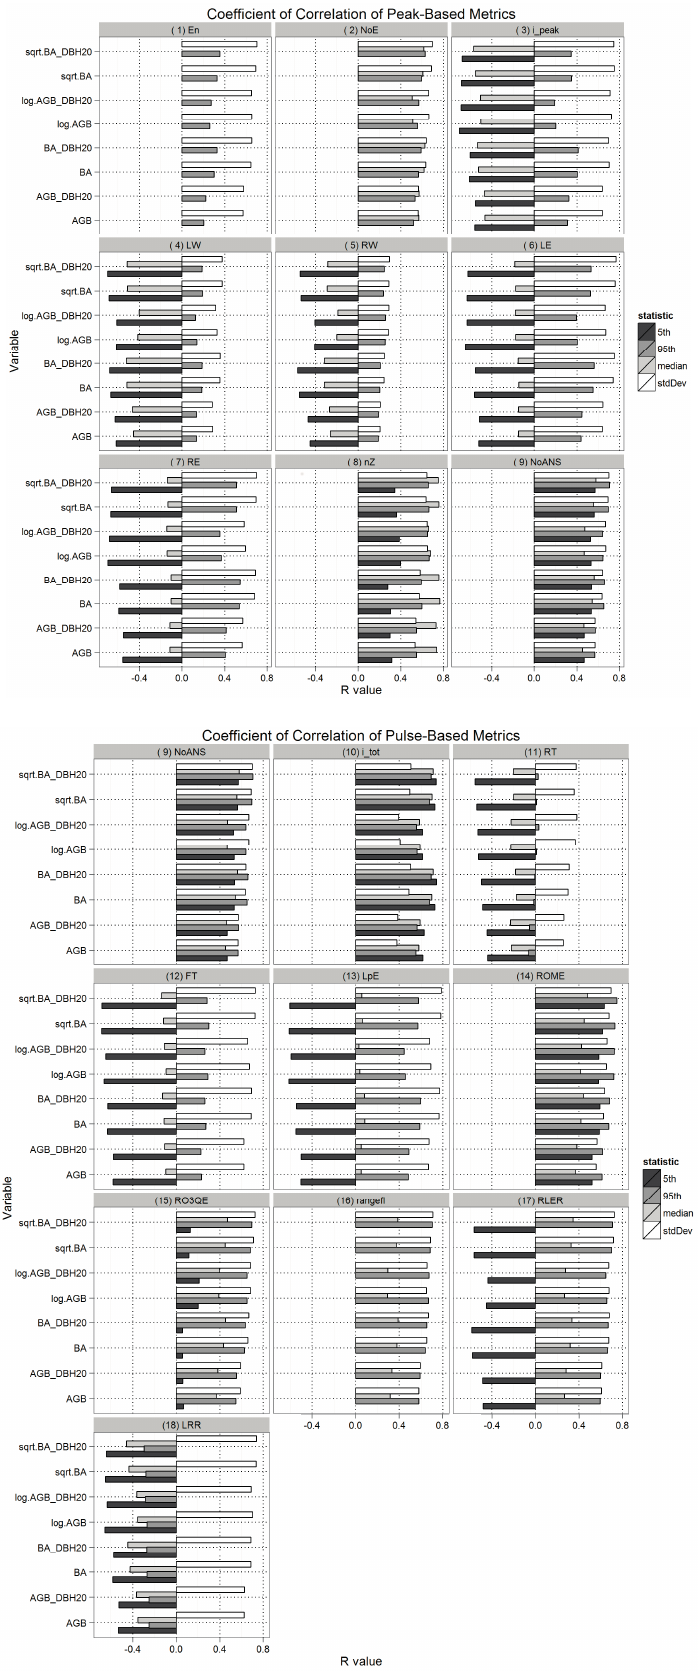
Figure 4. Aggregated representation of the correlation coefficient between variables and predictor distributions divided in ( top ) peak-based and ( bottom ) pulse-based